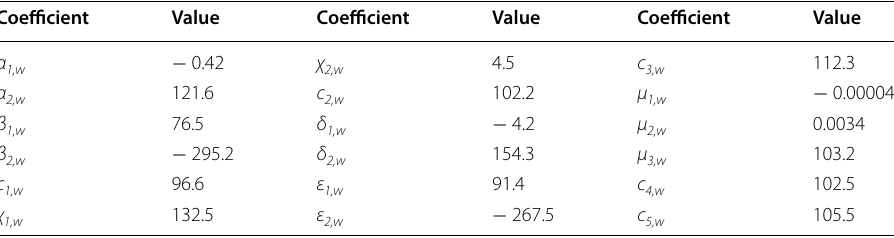
Table 2 Required coefficients for proposed model of warm white LED